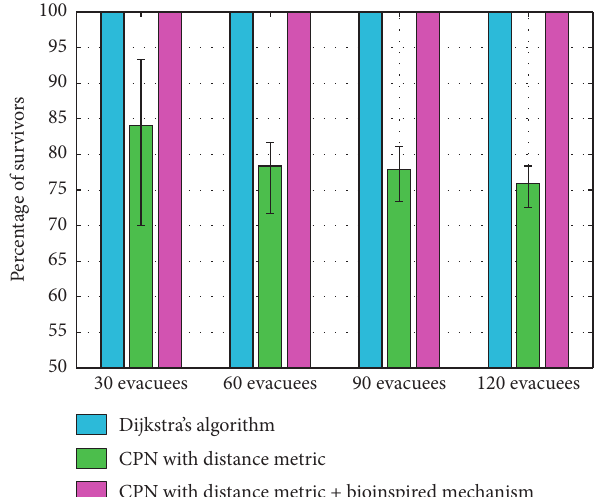
Figure 5: The percentage of survivors in the Canary Wharf building model for each scenario. The results are the average of five randomized simulation runs, and error bars show the min./max, result in any of the five simulation runs.